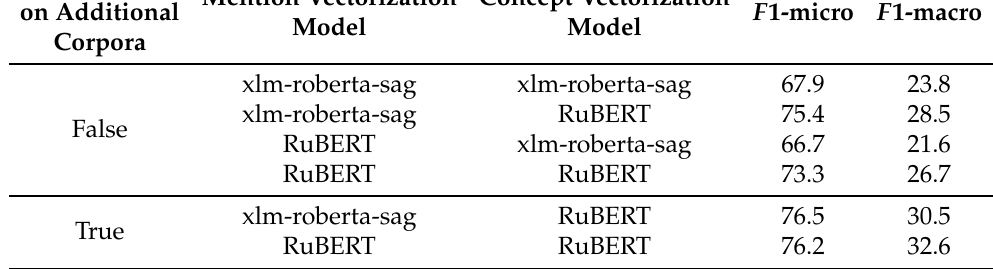
Table 4. Comparison of language models used in the normalization solution for RDRS.